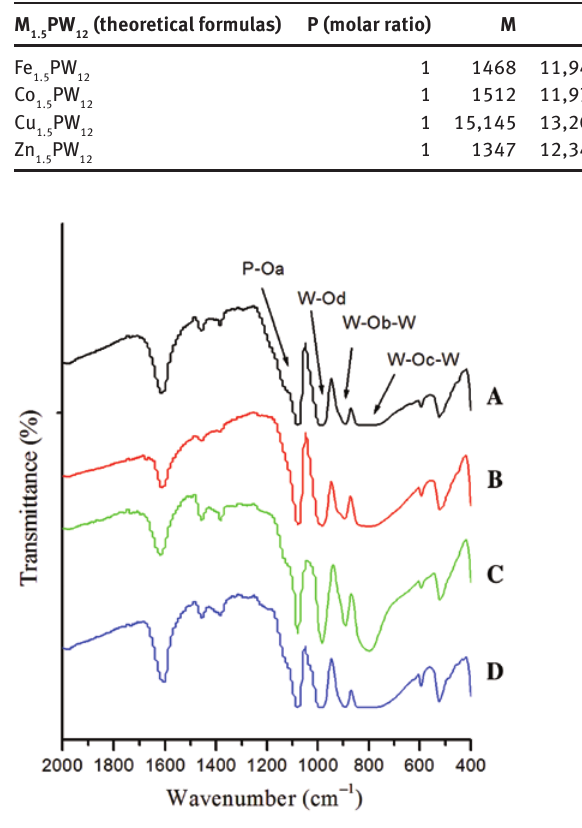
Figure 1: Fourier transform infrared (FTIR) spectra of the